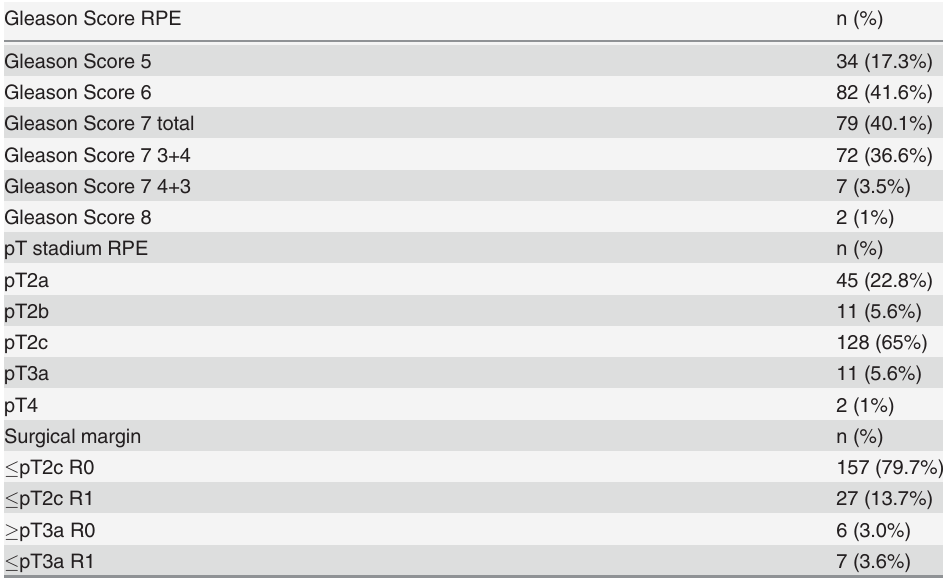
Table 4. Final GS grade and pathological tumor stage of RPE specimen Statistics: